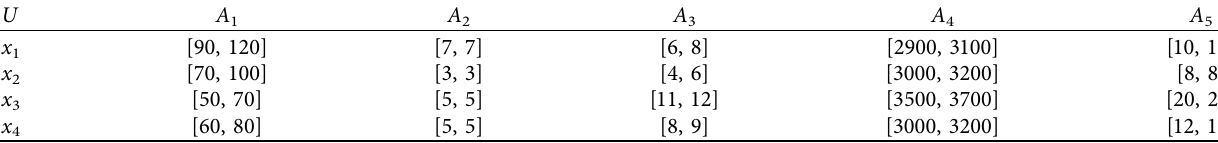
Table 1: Direct observation of quantitative indicators.